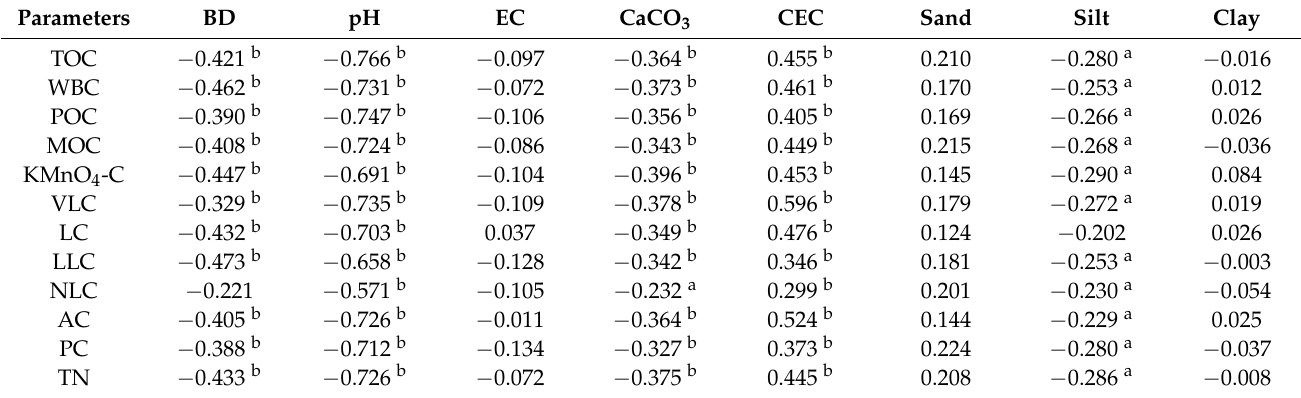
Table 6. Correlation coefficient (r) between soil properties and various organic C and N pools in soils under different land use systems.